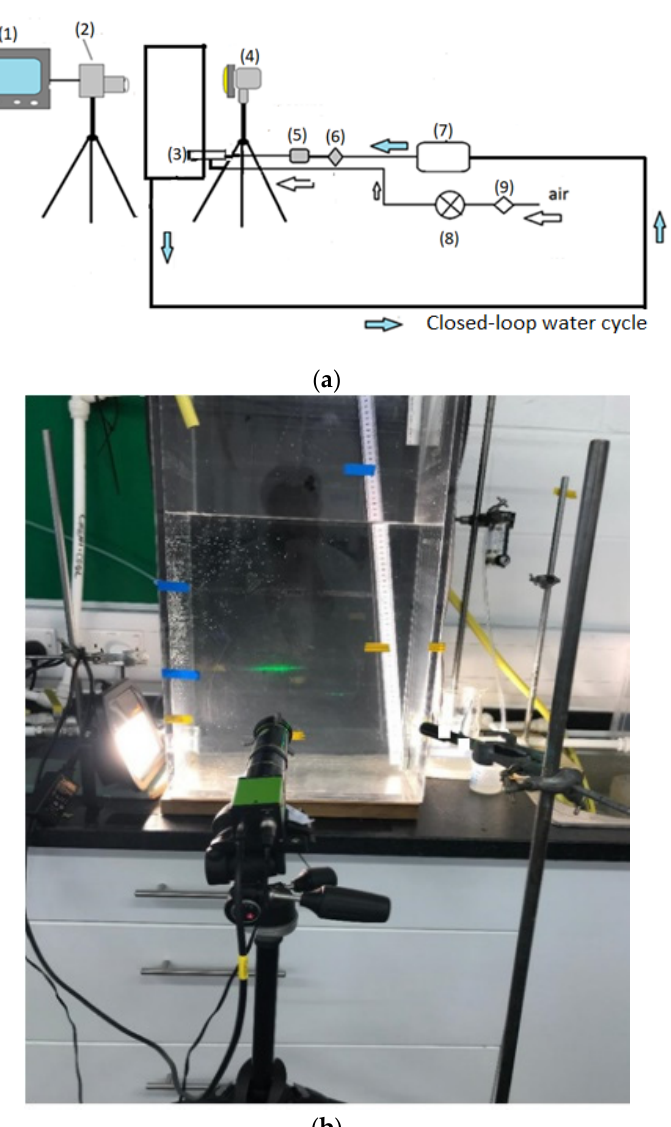
Figure 1. ( a ) Schematic diagram of the test rig. (1) Personal computer, (2) high ‐ resolution camera, (3) microbubble generator, (4) halogen lamp, (5) water pressure gauge, (6) water pump, (7) flow control valve, (8) air pressure gauge, (9) needle valve. ( b ) Photo of the test rig at Teesside Univer ‐